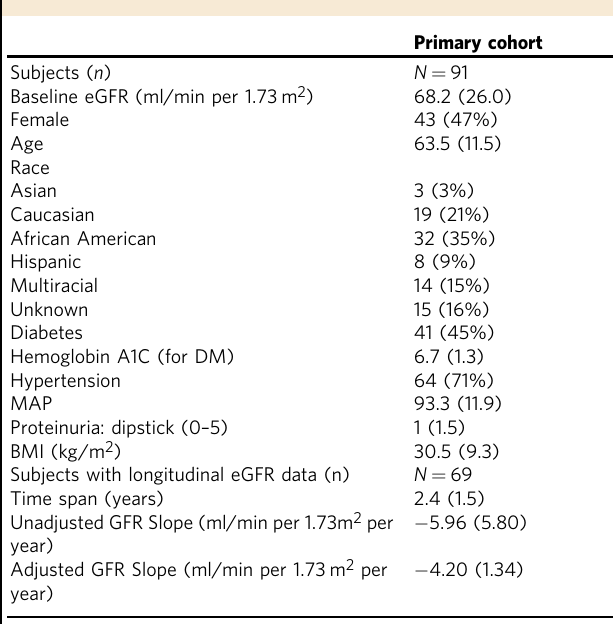
Table 1 Demographic and clinical characteristics of